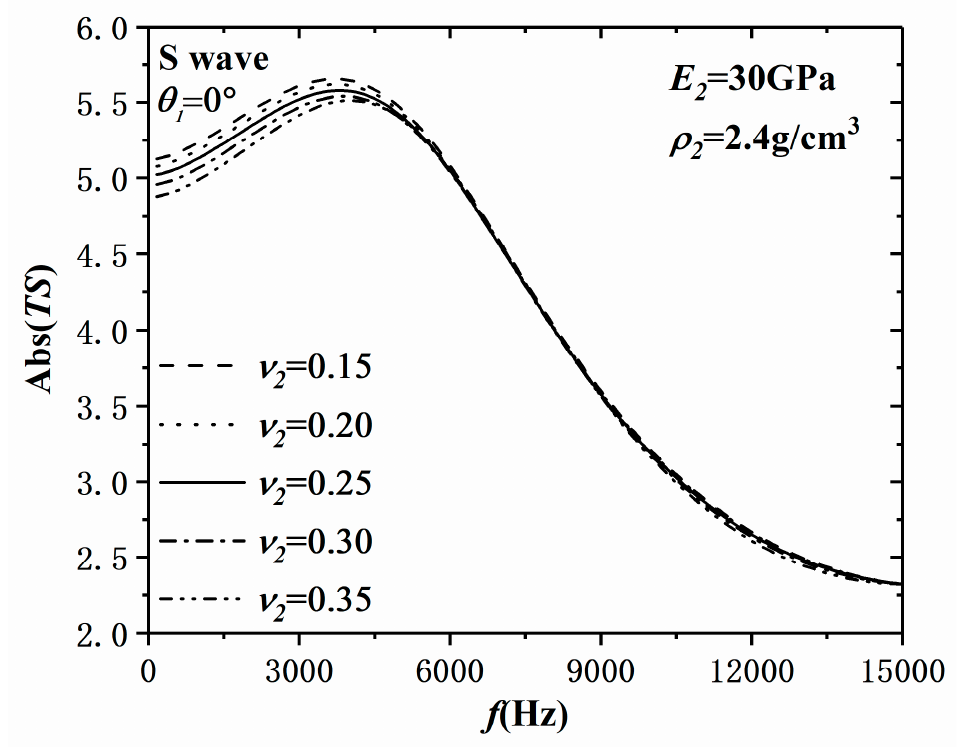
Figure 8. Influence of the Poisson’s ratio of the expansive grout on theoretical amplitude spectrum of gauge combination TS for the incident S wave. 225 Table 7. Influence of the Poisson’s ratio of the expansive grout on theoretical amplitude spectrum of 226 gauge combinations FS and TS for the incident S wave. 227